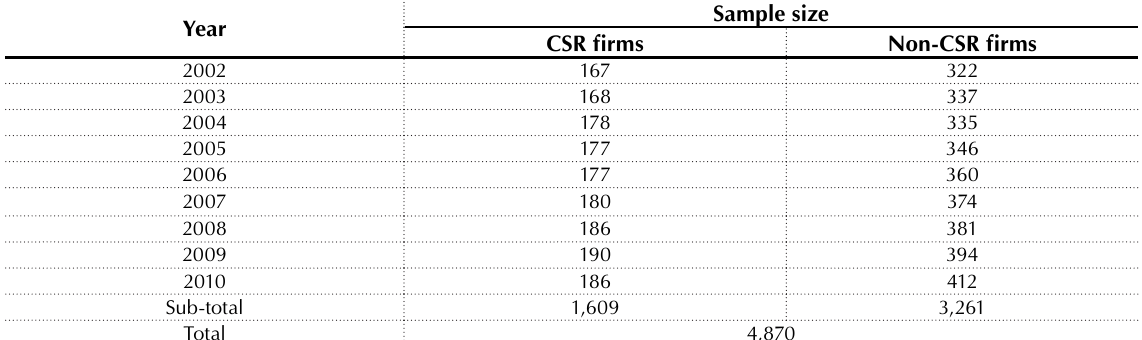
Panel A. CSR and non-CSR